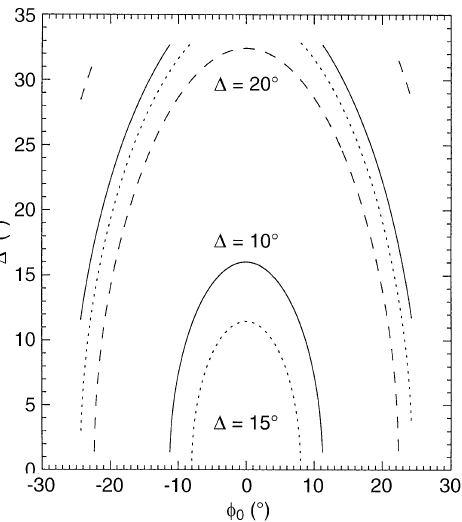
Fig. 5. Relationship between true (cid:68) ( " 10 ° , 15 ° , and 20 ° ) and cal- culated (cid:68) (cid:64) as a function (cid:47) (cid:48) , for the situation that backscatter originates behind the radar